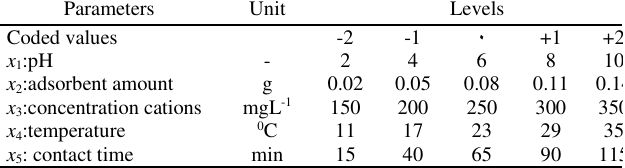
Table 1 Main parameters and their levels used in CCD. Table 1. Main parameters and their levels used in CCD.